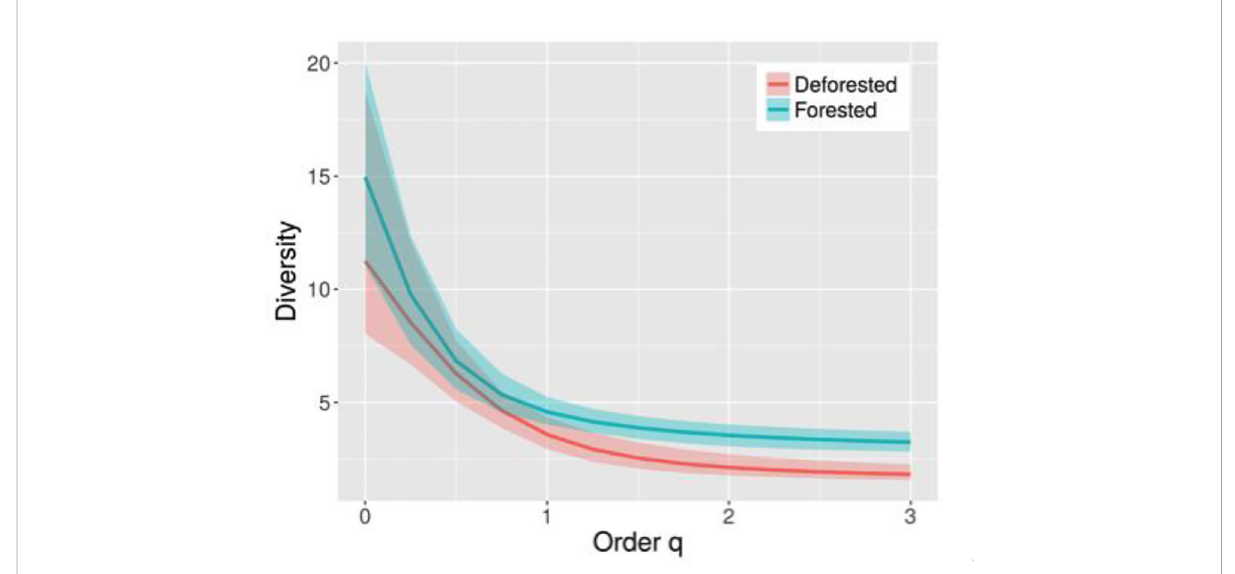
FIGURE 2 Estimated diversity pro fi les for bat species data in forested (green line) and deforested (red line) sites for q between 0 and 3 with 95% con fi dence interval (shaded areas based on a bootstrap method of 1000 replications). The numbers show the estimated diversities for q = 0, 1, 2 and